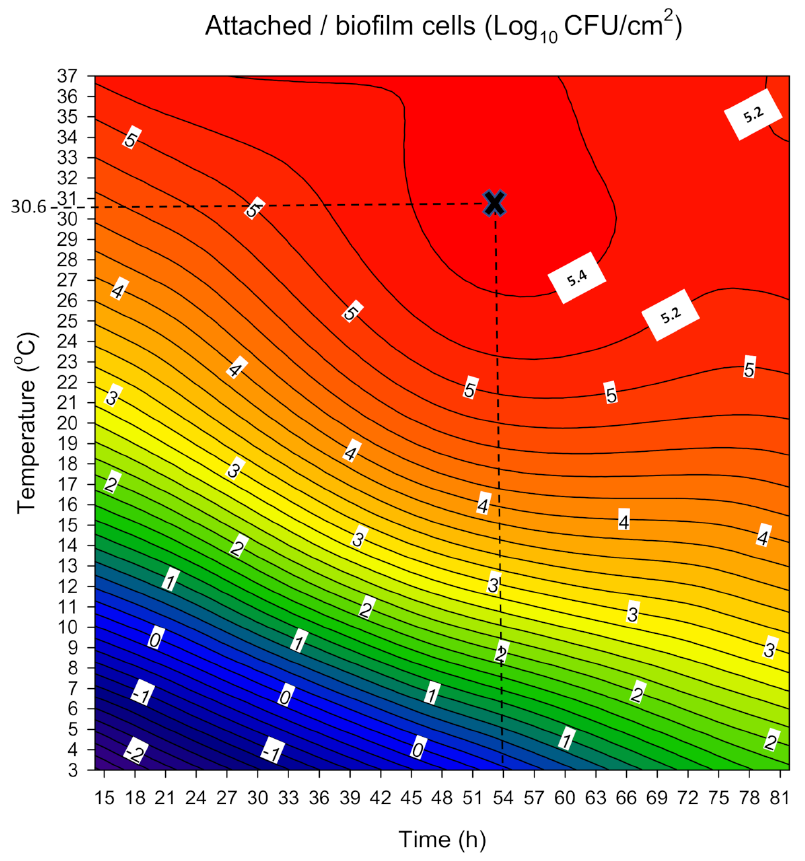
Figure 2. Contour plot describing the interactive influence of incubation time and temperature on the concentration of the attached SS coupons population (Log 10 CFU/cm 2 ) of the four-strain L. monocytogenes cocktail. This plot was constructed by considering the predictions of all experiments included in the central composite rotational design (CCRD) ( n = 20; i.e., those shown in Table 1). Dotted lines illustrate time and temperature conditions predicted maximizing sessile population (i.e., 54 h at 30.6 ◦